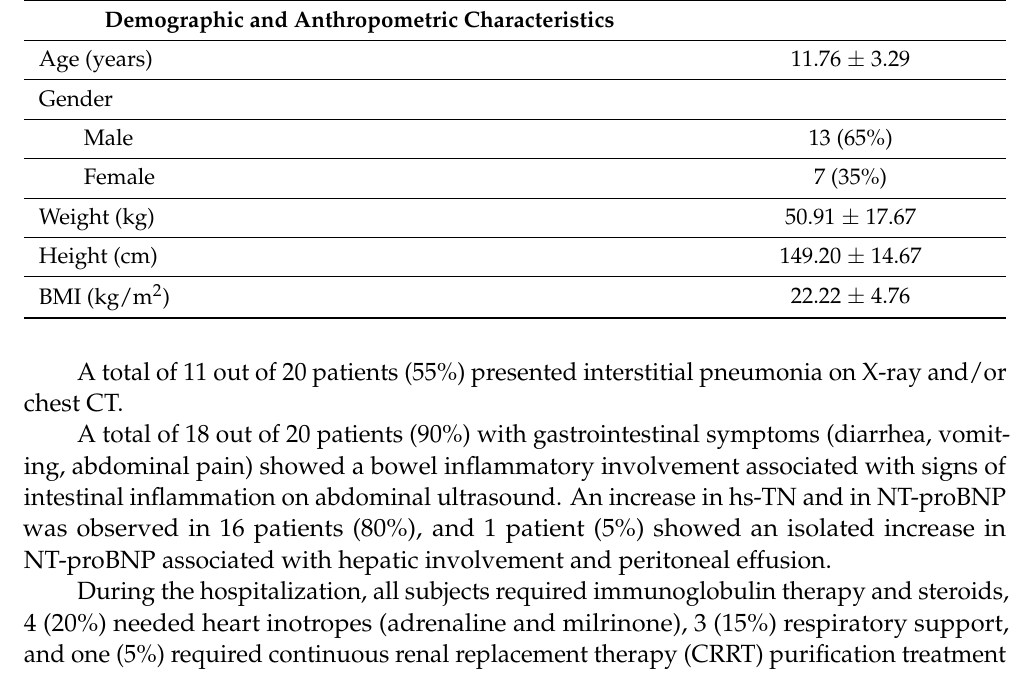
Table 1. Main demographic and anthropometric characteristics of our cohort at cardiopulmonary exercise test. Data are expressed as mean (and standard deviation) or as count (and percentage). Legend: BMI = body mass